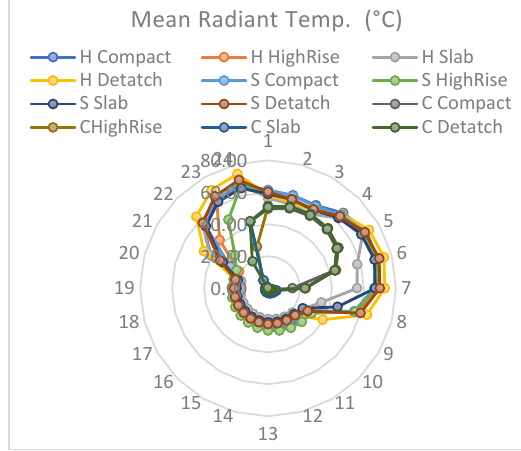
Fig. 13: Mean Radiant Temp on the hottest, coldest and sultriest day of the year in the form of four morphotypes in the current situation